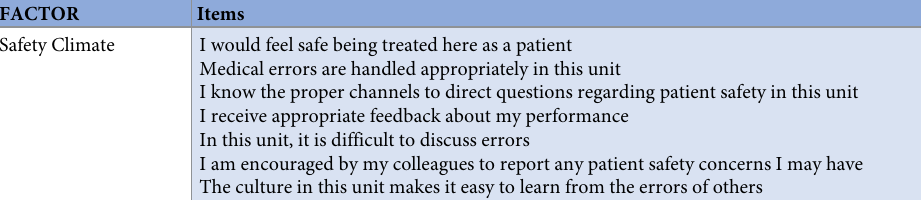
Table 1. Safety Attitudes Questionnaire (SAQ) factors and